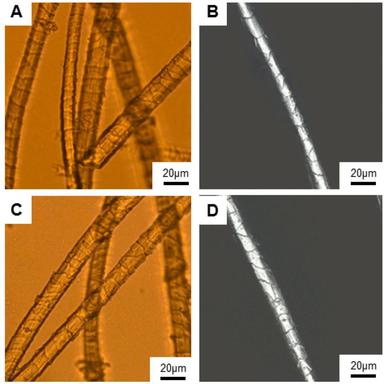
Light microscopy (left) and laser scanning photomicrograph (right) pictures of wool fibres treated for 240 min with 10 g/L solutions of NaBH4 (a and b) and pristine wool fibres (c and d).